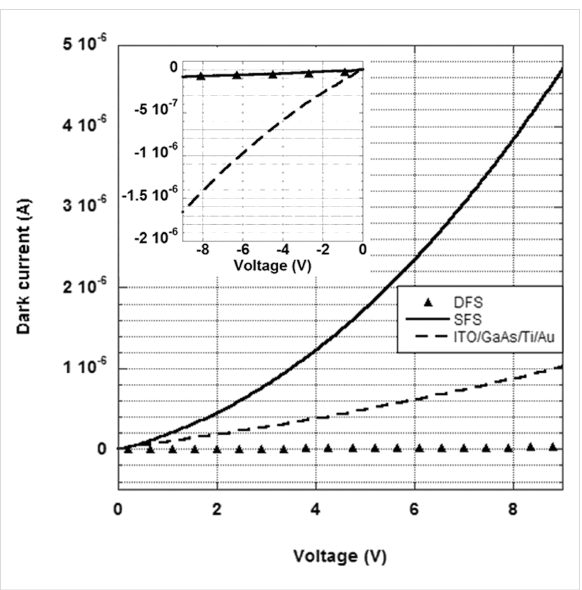
ITO/GaAs equivalent resistance increases, thus limiting the forward bias voltage drop at the GaAs/Ti/Au Schottky contact with subsequent reduction of the forward current. Then